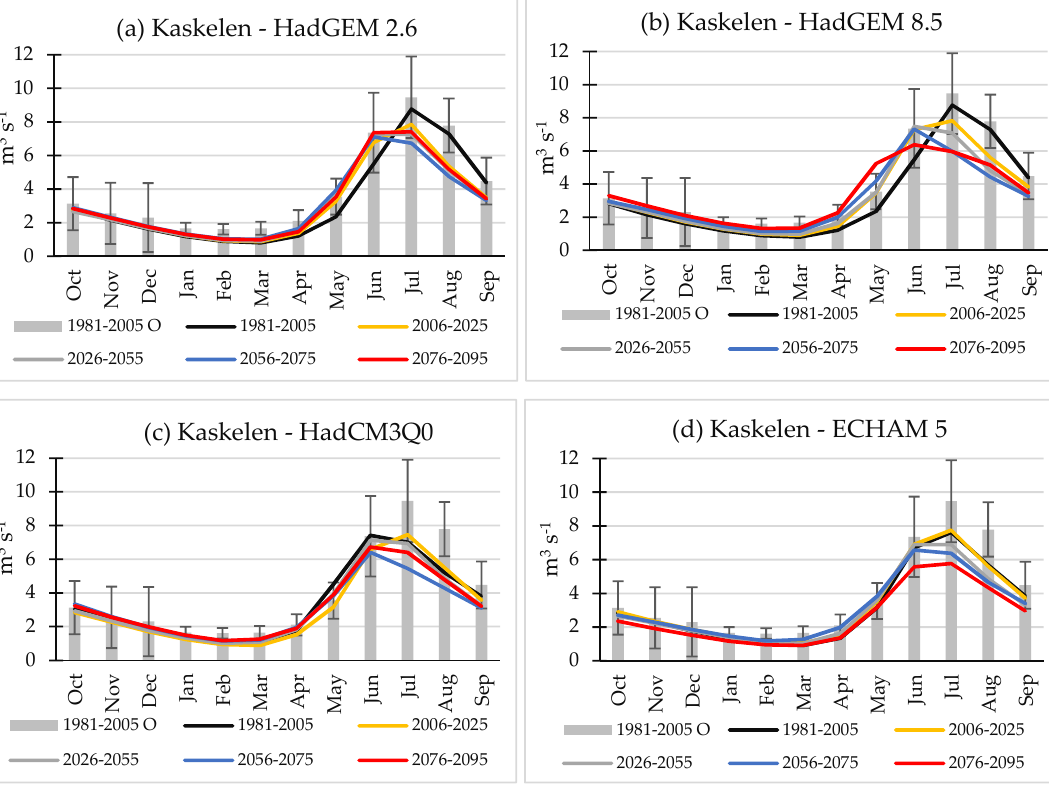
Figure 16. As in Figure 12 but for the Turgen. 4.3.1. Simulation of Flow Using Biased-Corrected PRECIS Data for the Baseline Period In the baseline period (1981–2005, grey bars and black line in Figures 12–16), HBV-ETH reliably simulates the annual cycle of streamflow in all catchments and for all climate scenarios. Glacier areas derived from the satellite imagery were used in this period and, therefore, uncertainties of the baseline hydrological simulations are mainly associated with model calibration and, more importantly, the quality of climate model output which serves as input for HBV-ETH. Thus in the Kishi Almaty (Figure 12), streamflow simulations based on RCM output is very close to the observed flow and this is consistent with high model efficiency during the calibration and validation years. In the Ulken Almaty and the Talgar catchments, an underestimation of flow in August, a month dominated by the glacier and ground-ice melt, is evident (Figures 12 and 13) similarly to the calibration and validation years (Figure 9).